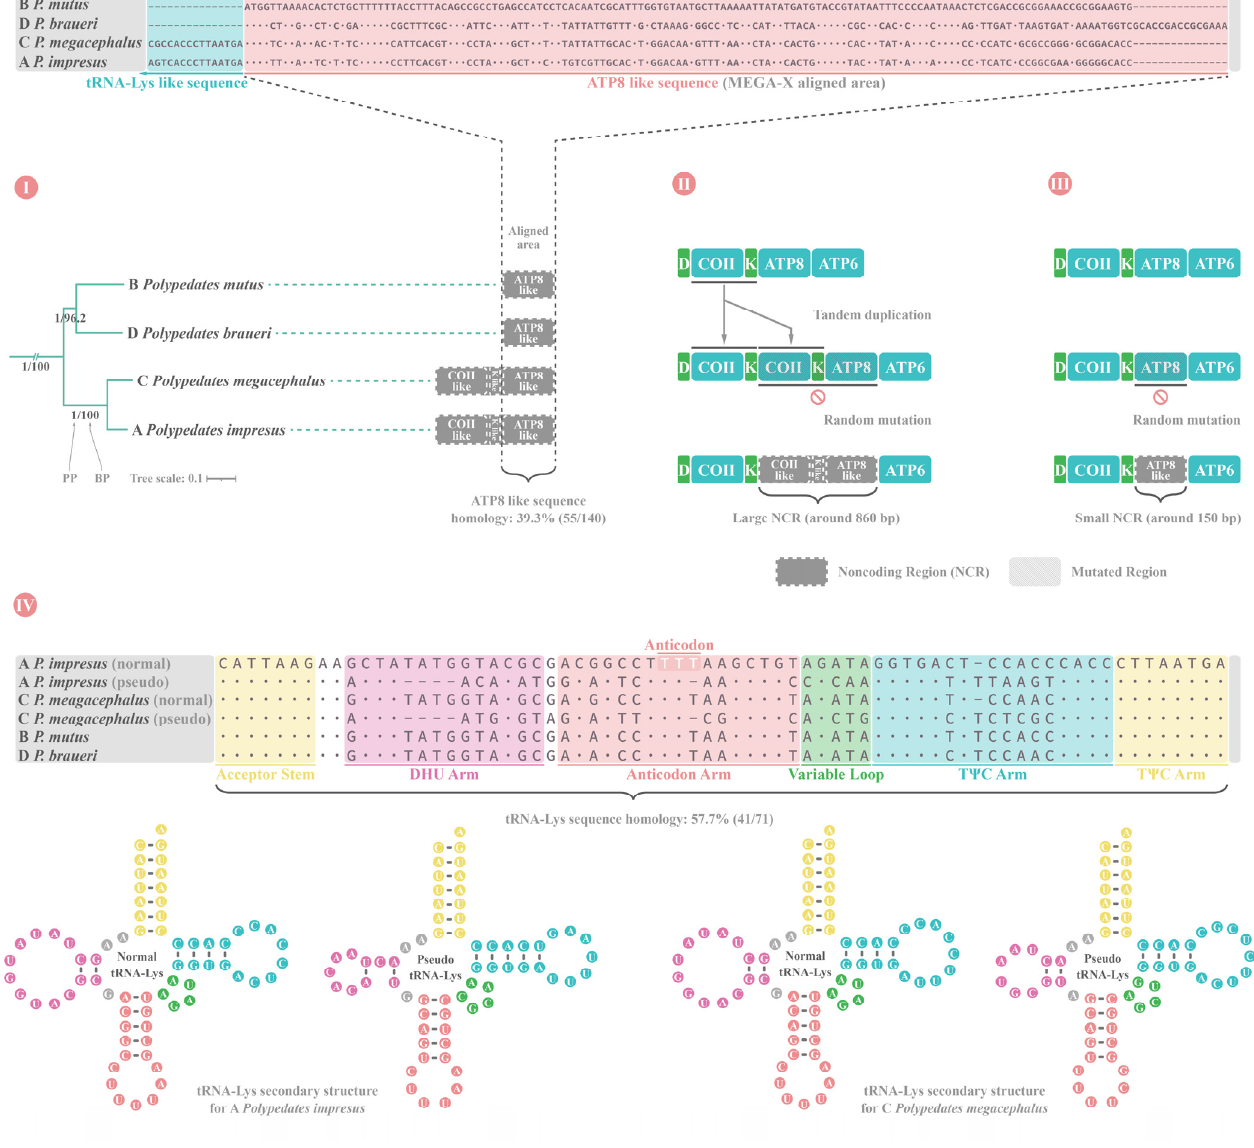
Figure 8. Diagram of the presumptive noncoding region (NCR) formation pathway and component analysis of four Polypedates frogs. ( I ) Phylogenetic relationship for four Polypedates and their NCR sequence alignment; ( II ) Putative NCR formation pathway for Polypedates impresus and Polypedates megacephalus ; ( III ) Putative NCR formation pathway for Polypedates mutus and Polypedates braueri ; ( IV ) Gene tRNA Lys sequence alignment and secondary structure prediction for four Polypedates . The length of features was not drawn to match their actual nucleotide proportion in the